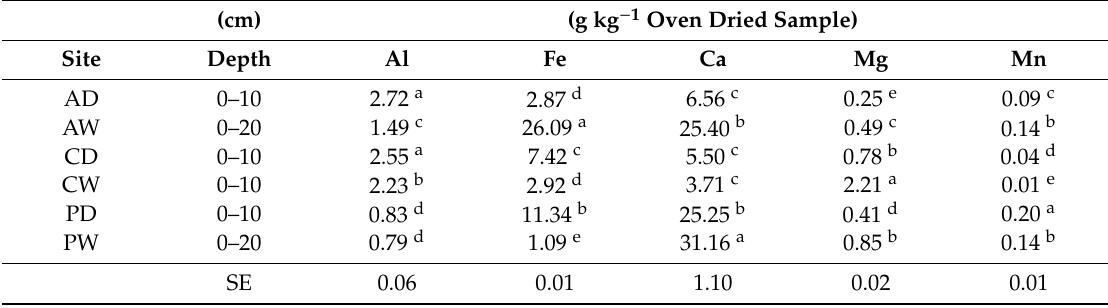
Table 4. Selected elements recovered by a single step extraction of the NaOH-Na 2